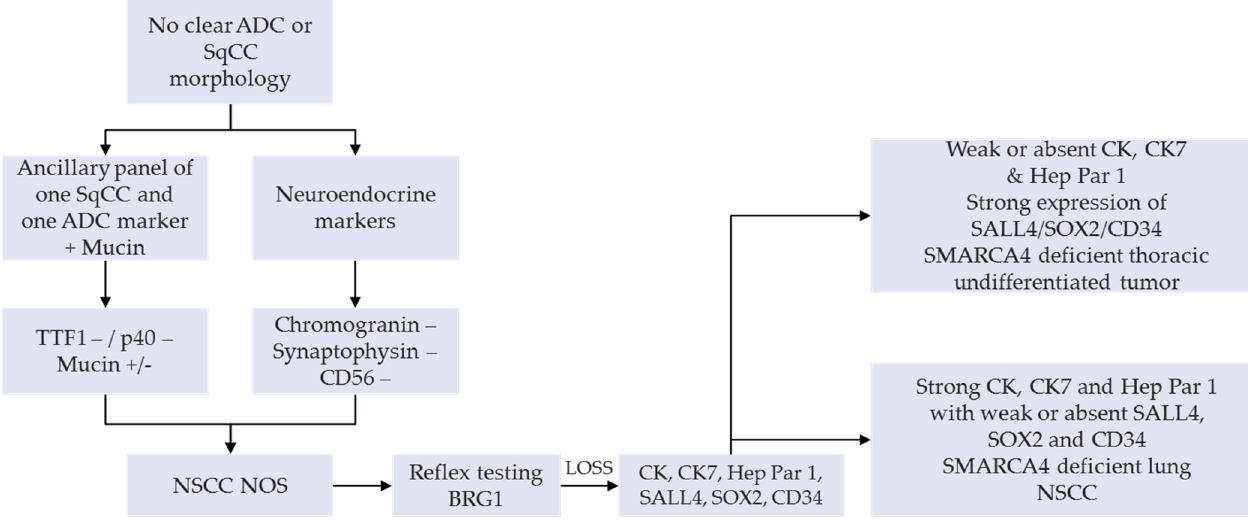
Figure 3. Proposed diagnostic algorithm on small diagnostic samples, including the reflex testing for the anti-BRG1 immunohistochemistry analysis in order to identify the thoracic SMARCA4-deficient undifferentiated tumors. Abbreviations: ADC, adenocarcinoma; NOS, not otherwise specified; NSCC, non-small cell carcinoma; SqCC, squamous cell carcinoma.